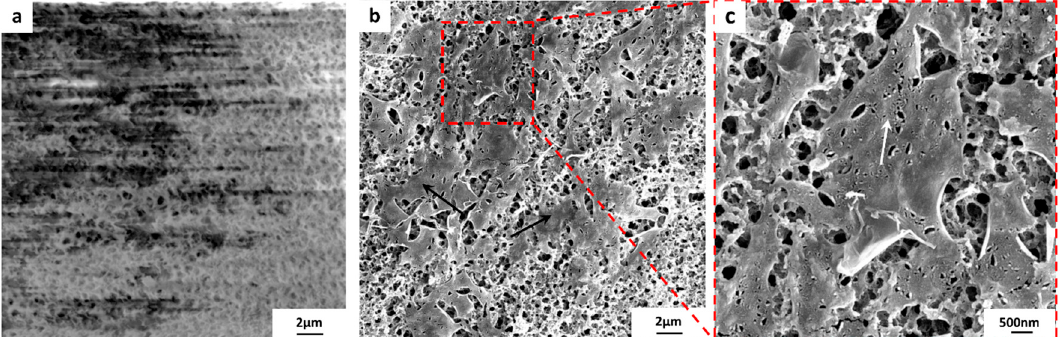
Figure 15. FESEM micrographs of the transferred graphene (~1 × 1 cm 2 ) onto PVDF 4 substrate, ( a ) because the graphene is discontinuous (therefore, unable to conduct away electrons), artifacts are present even at low beam current; ( b ) FESEM of coated graphene/PVDF 4 composite, arrows indicate the discontinuous graphene batches; ( c ) high magnification FESEM micrograph shows the tears within the graphene layer and also shows the PVDF 4 substrate pores underneath. Materials 2017 , 10 , 86